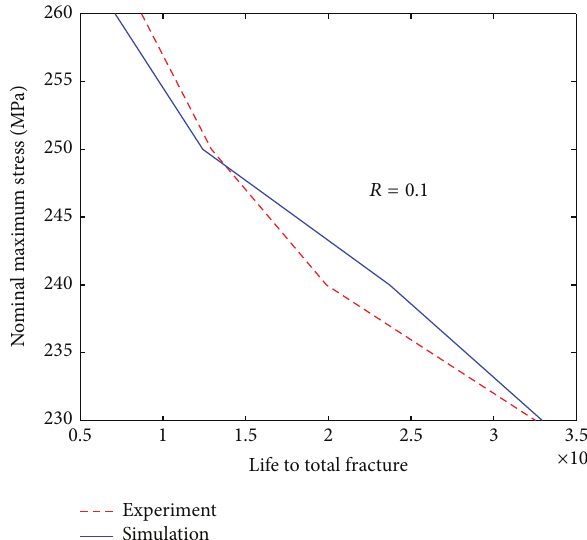
Figure 5: The fatigue life prediction results of notched